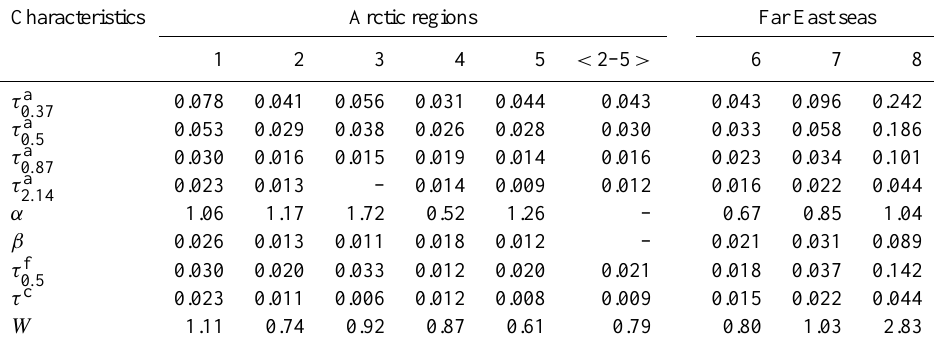
Table 3. Average characteristics of AOD and water vapor content in Arctic and Far East seas (the geographic positions of regions 1–8 are presented in Fig. 1 and in Table